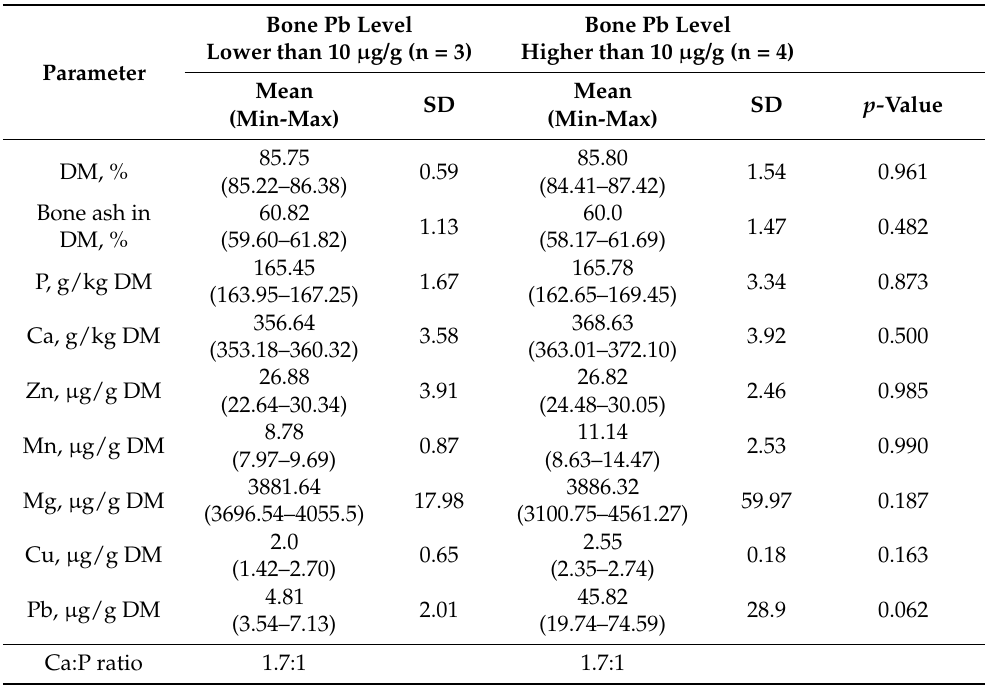
Table 1. Means, minimum, maximum, and standard deviation (SD) values for the bone composition in the tibiotarsi of the White-Tailed Sea Eagles with bone Pb level lower than 10 µ g/g and higher than 10 µ g/g and differences between means ( p